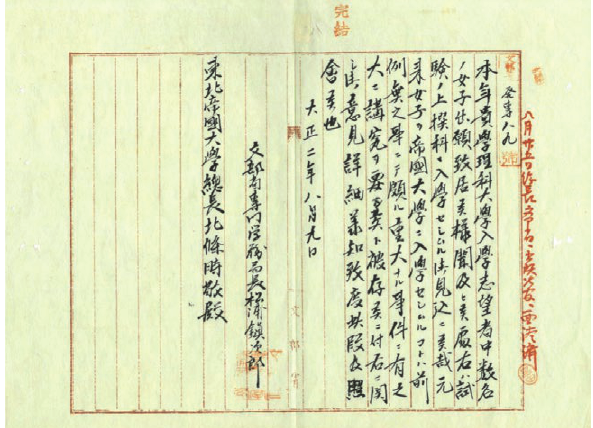
Figure 1. Hand written letter from the Ministry of Education to the President of Tohoku University 9 August 1913 (received from Tohoku University Library Archive 13.12.2020, publication permis- sion 7.2022). On the right side of the letter, it is written in red let- ters that the President of Tohoku University went to the Ministry of Education to attend a meeting on August 25 th . No record was made of what transpired at the meeting. (Courtesy of Tohoku University Archives).